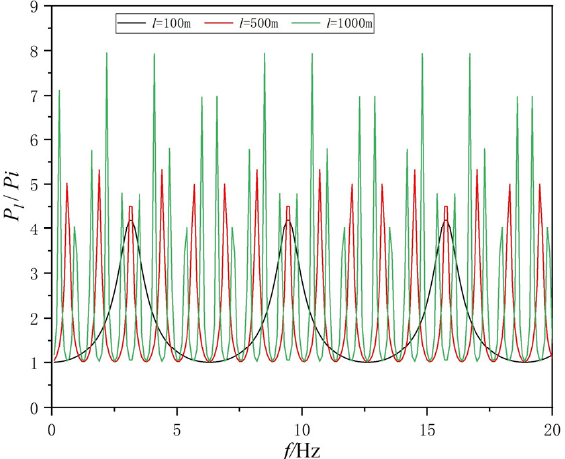
Figure 15. Amplitude-frequency characteristics of different lengths of tubular strings.